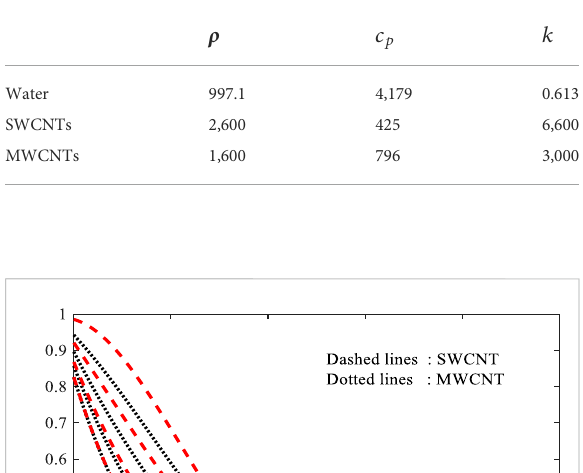
TABLE 2 Thermophysical properties of water and nanotubes (Reddy and Kumar, 2021).